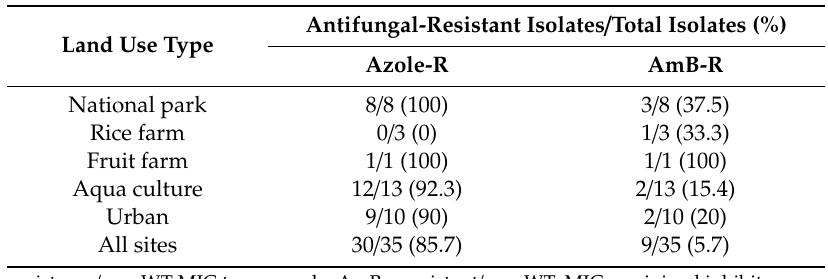
Table 2. Prevalence of resistant / non-wild type phenotype amongst A. flavus sensu stricto isolates from the Mekong Delta Region of Vietnam by land-use type.